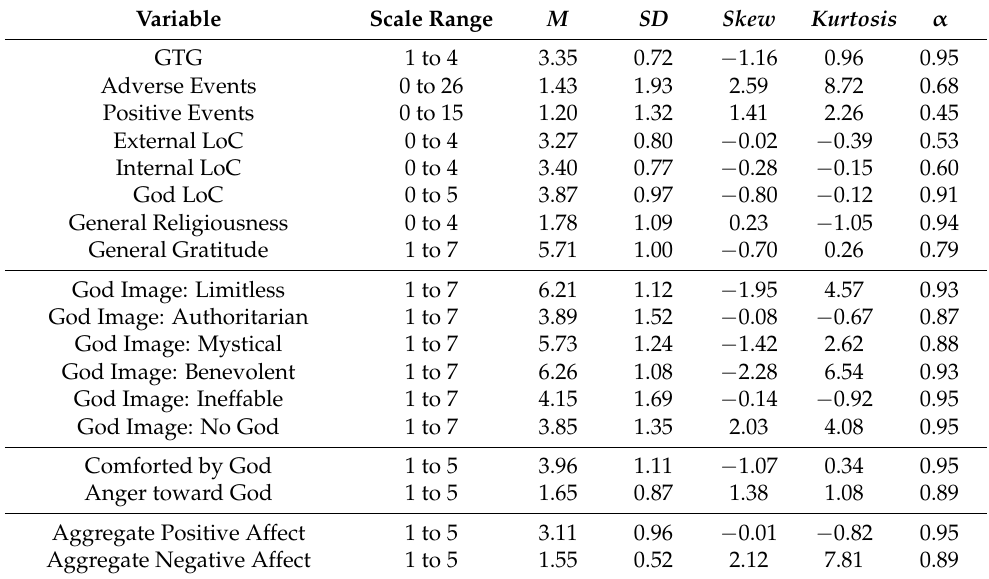
Table 4. Descriptive Statistics for Baseline Measures and Aggregated Positive/Negative